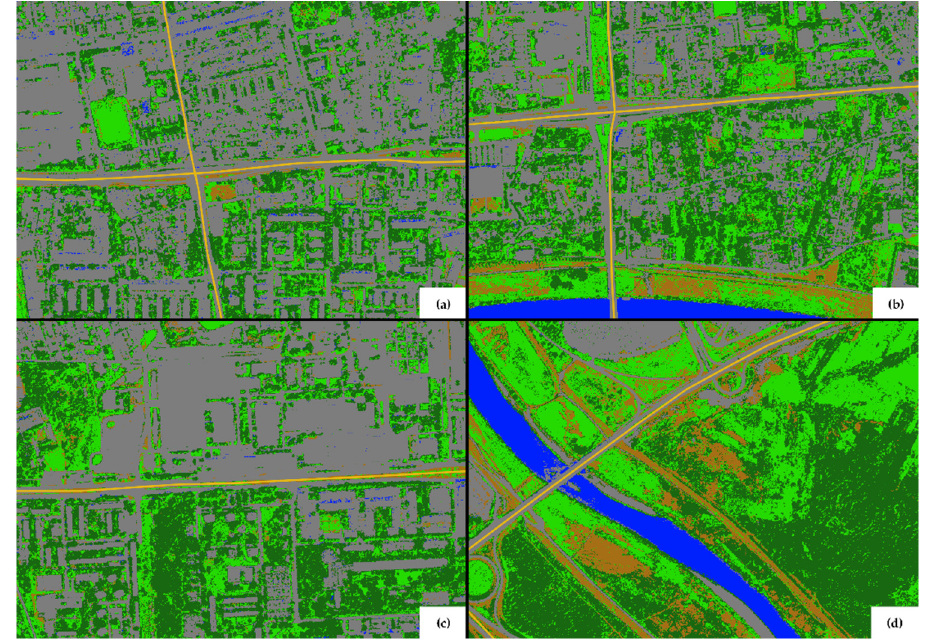
Figure 6. Possibilities for plants that reduce air pollutants [38].